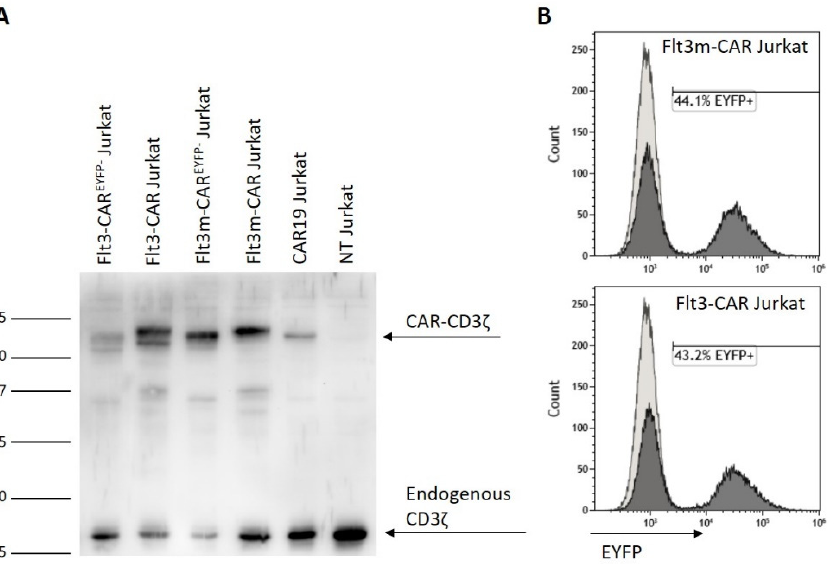
Figure 4. Generating Flt3m-CAR Jurkat cells. ( A ) In Western blot images, the synthesis of chimeric antigen receptors was demonstrated. The bands corresponding to the CD3 ζ chain that belongs to CAR receptors appeared in the lines with CAR Jurkat cell lysates (50–60 kDa), but not in the line with non-transduced (NT) Jurkat cell lysates. The bands corresponding to the CD3 ζ chain as part of endogenous T-cell receptors (16 kDa) are present in all lines. ( B ) EYFP synthesis in Flt3m-CAR Jurkat cells was assessed on the seventh day after transduction using flow cytometry.